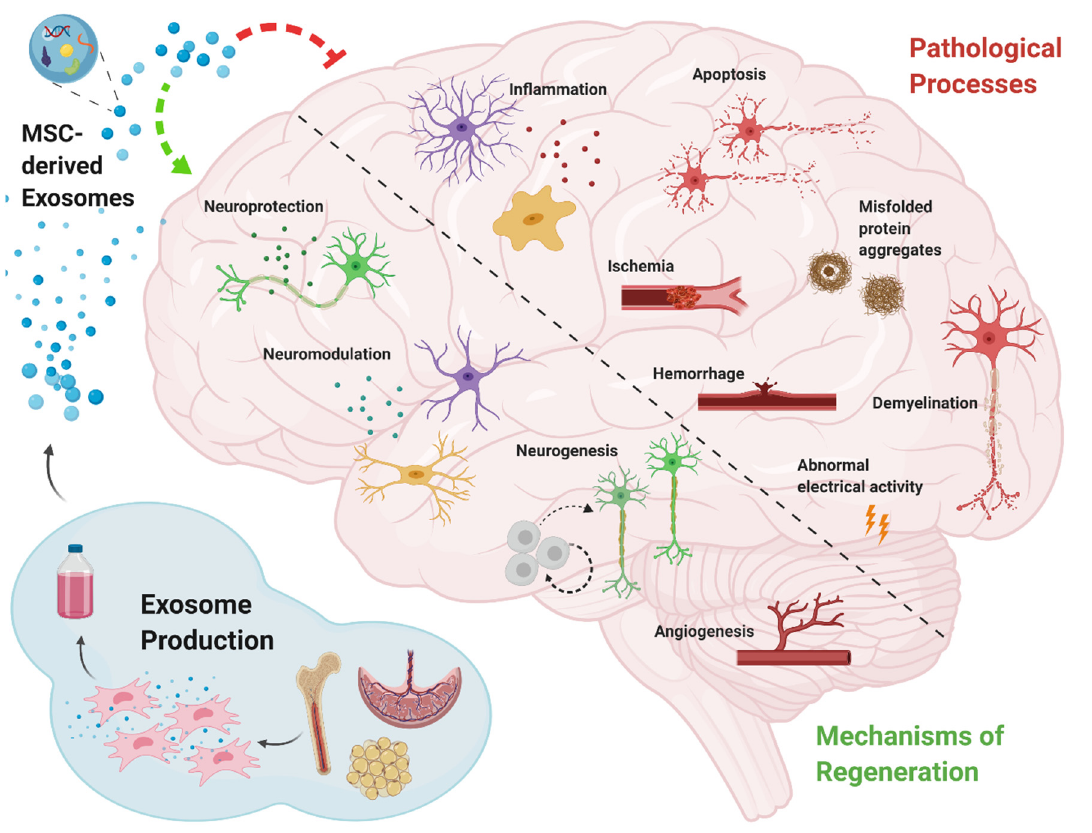
Figure 1. Schematic diagram depicting the major pathological processes in neurodegenerative diseases, and the key mechanisms through which mesenchymal stem cell-derived exosomes operate in order to mitigate these pathologies and induce regeneration.